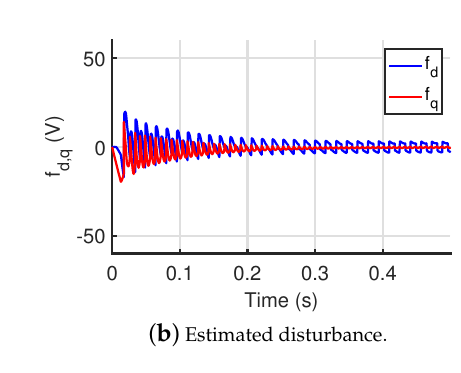
Figure 5. Simulation results under L = 2 L 0 .